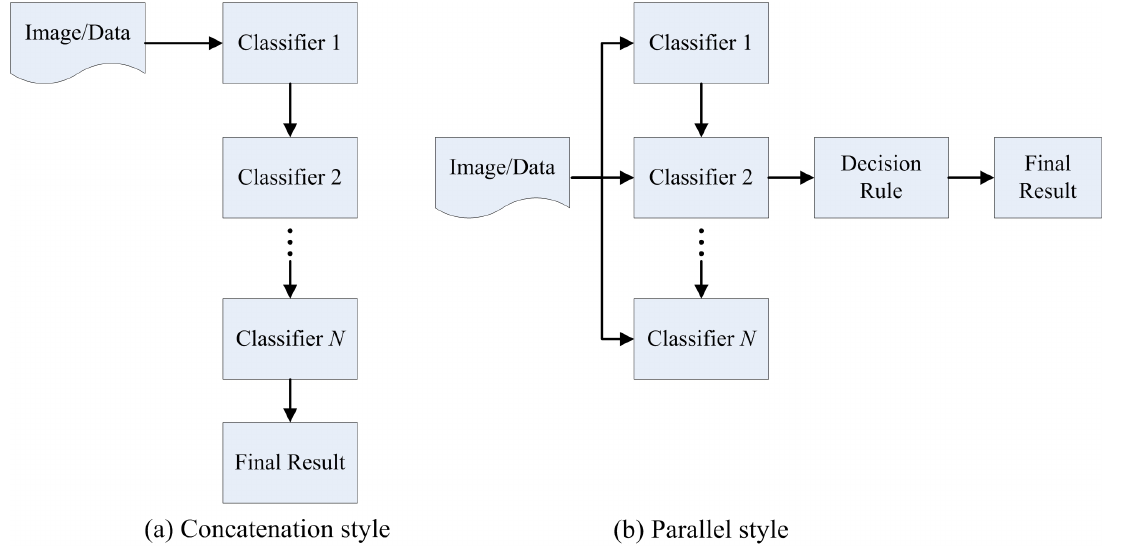
Figure 1. The combination style in